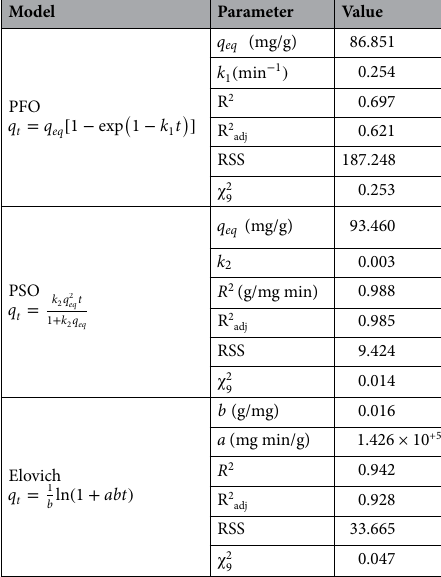
Table 6. Kinetics parameters for Pb 2+ adsorption on the optimum activated hydrochar (AHC op